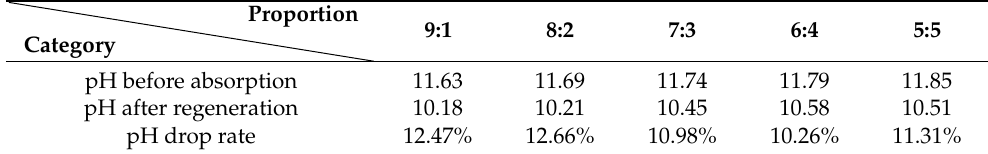
Table 7. pH of AEP-DPA composite system before absorption and after desorption (Six cycles). Category